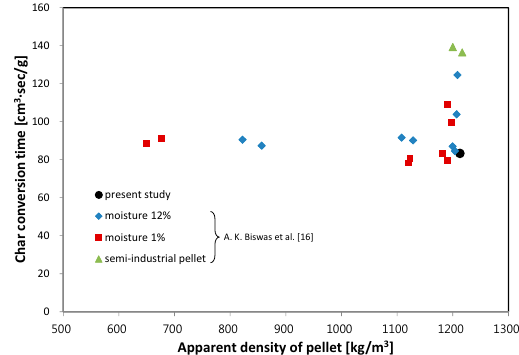
Figure 11. Comparison of standardized char conversion time (cm 3 ·s/g) between result of present study and previous research data by Biswas et al. [18].